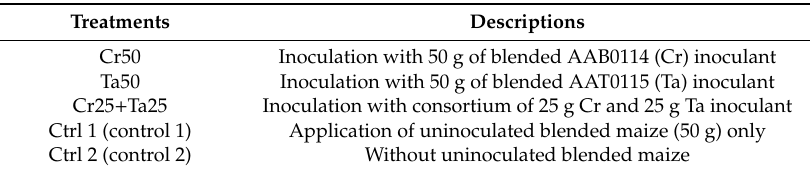
Table 1. Treatments and controls with their respective descriptions adopted for plant-growth-promoting experiment using AAB0114 (Cr) and AAT0115 (Ta)